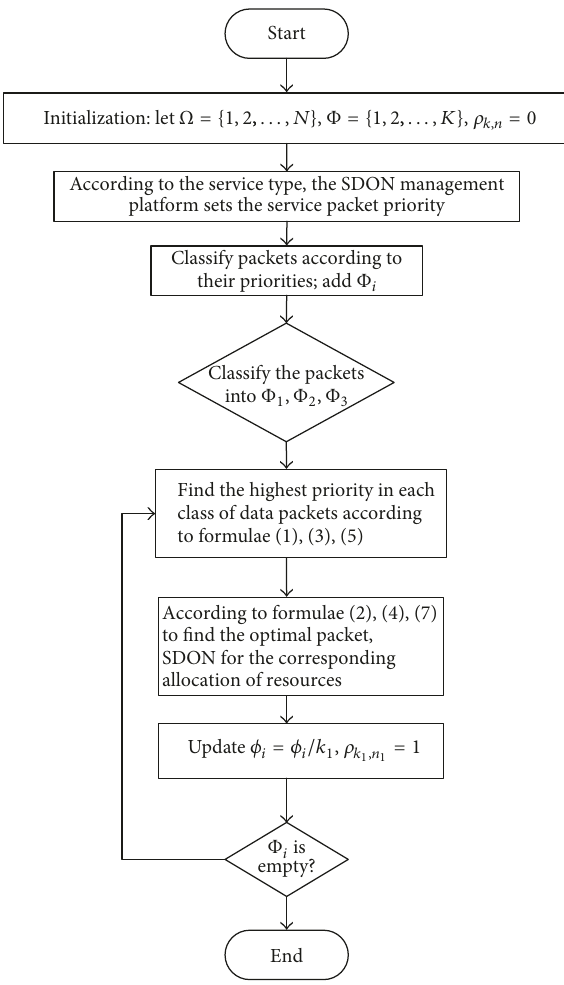
Figure 3: Structure of uplink dynamic scheduling algorithm.